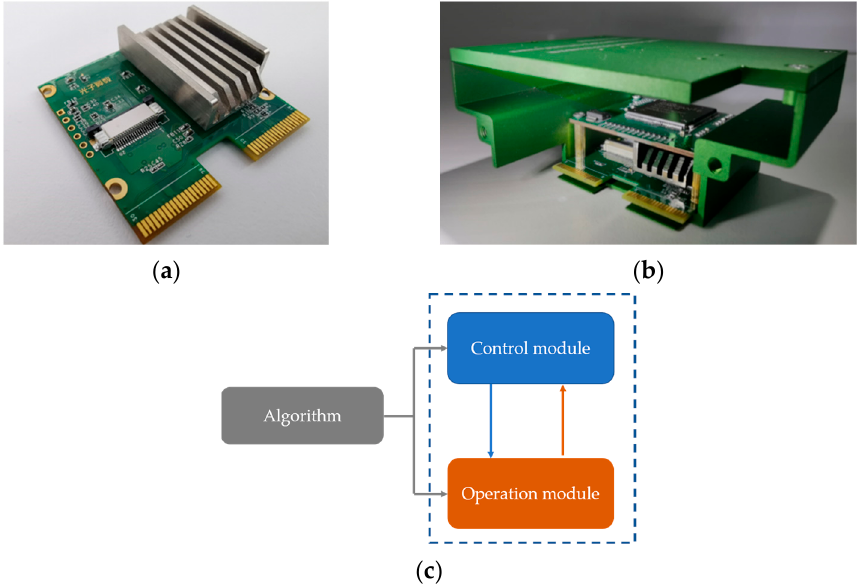
Figure 11. ( a ) The optical operation module. ( b ) The integrated module. It is a two-layer module with a separate control and calculation. The top is the control module, and the bottom is the optical operation module. ( c ) The work principle.